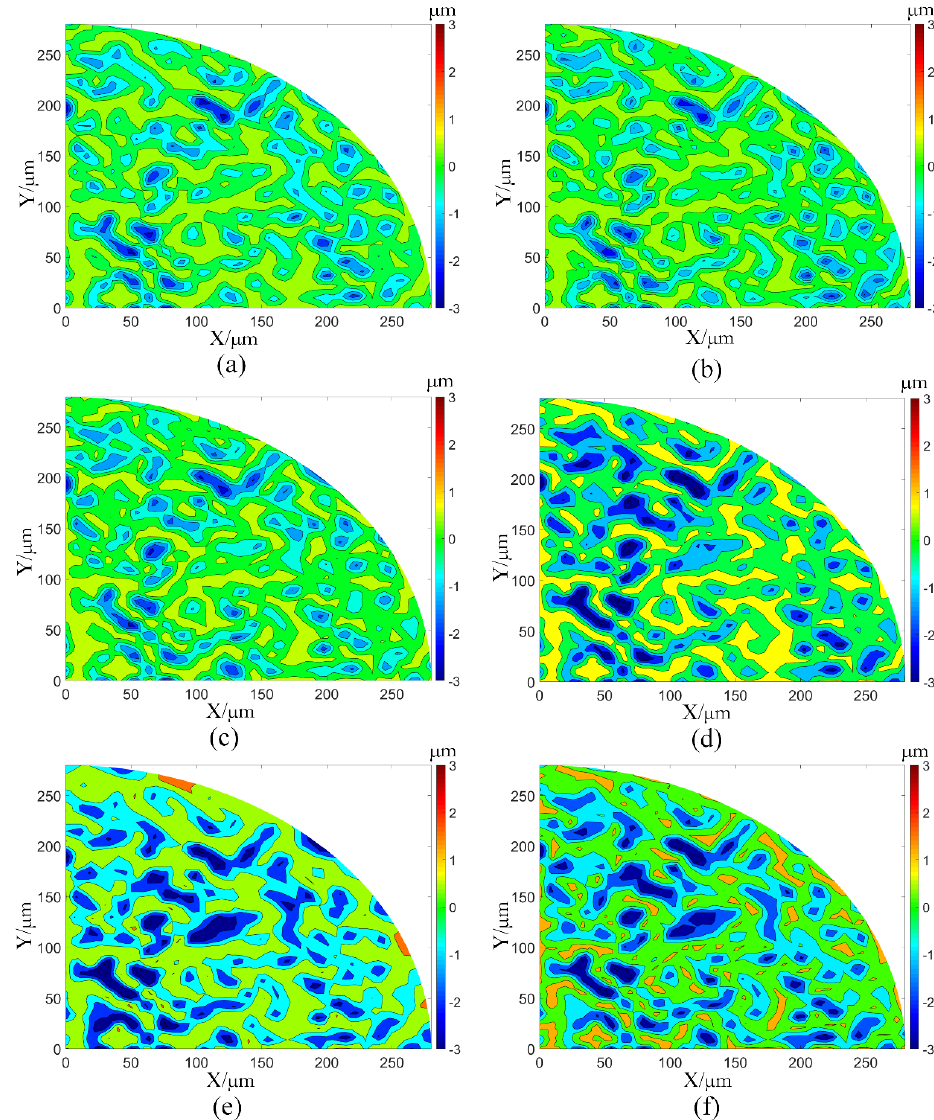
Figure 11. Surface morphology of the deformed specimens with various grain orientations; ( a ) d = d = 50 µ m, #1; ( b ) d = 50 µ m, #2; ( c ) d = 50 µ m, #3; ( d ) d = 120 µ m, #1; ( e ) d = 120 µ m, #2; and ( f ) 50 μm, #1; ( b ) d = 50 μm, #2; ( c ) d = 50 μm, #3; ( d ) d = 120 μm, #1; ( e ) d = 120 μm, #2; and ( f ) d = 120 d = 120 µ m, μm, #3.